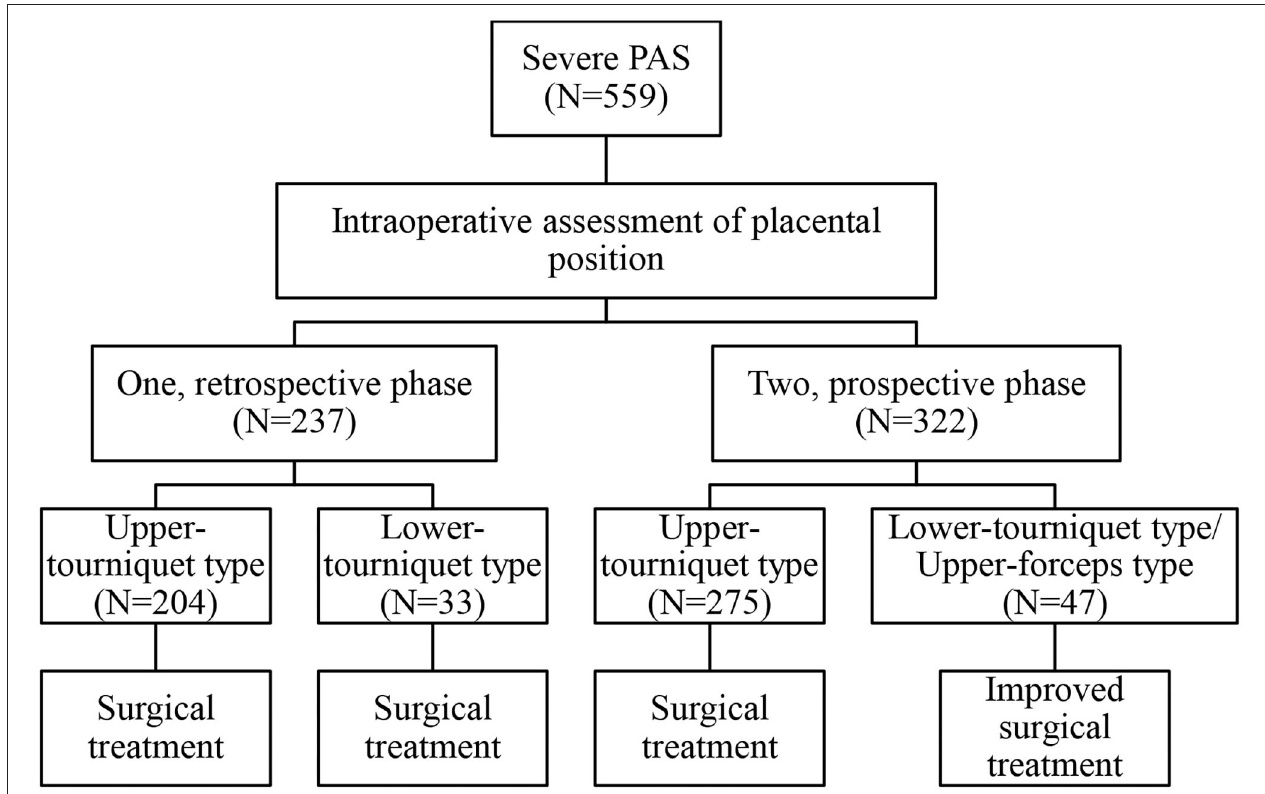
FIGURE 1 | Flow chart of the study. PAS, placenta accreta spectrum.